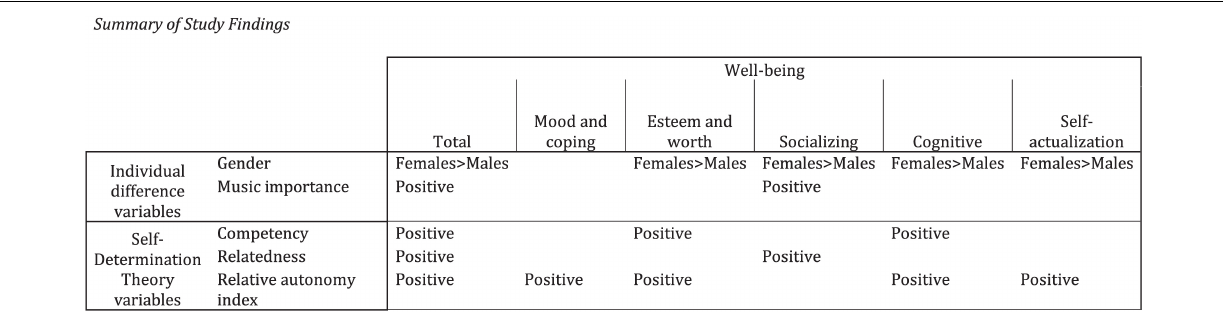
FIGURE 1 | Summary of study